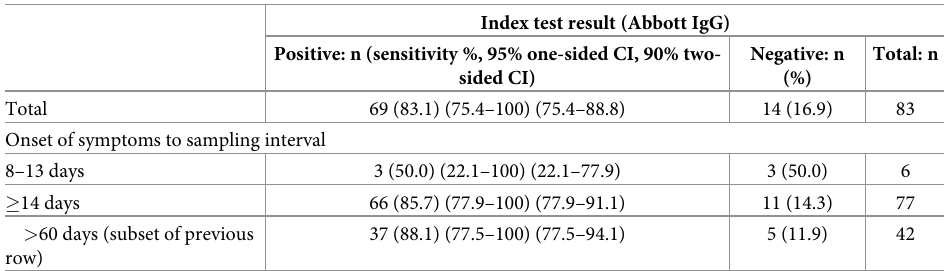
Table 2. Performance